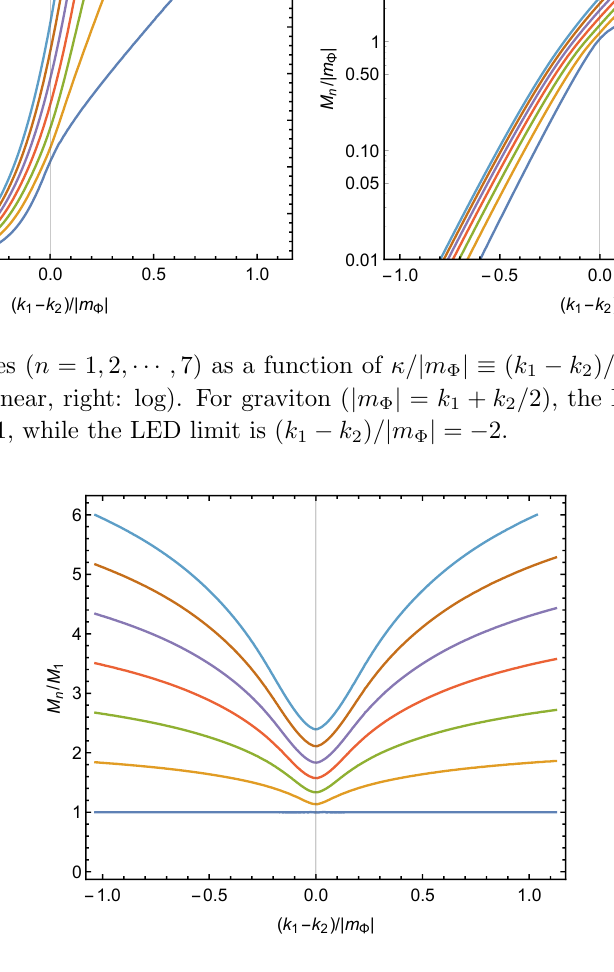
Figure 2 . KK masses ( n = 1 ; 2 ; (cid:1) (cid:1) (cid:1) ; 7) relative to the (cid:12)rst KK mass M 1 as a function of (cid:20)= j m (cid:8) j (cid:17) ( k 1 (cid:0) k 2 ) = j m (cid:8) j for (cid:12)xed values of m (cid:8) and R